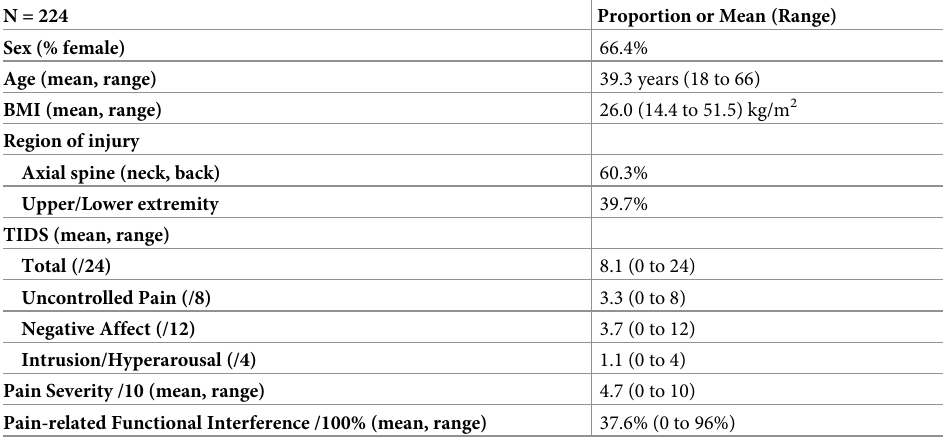
Table 1. Baseline characteristics and study